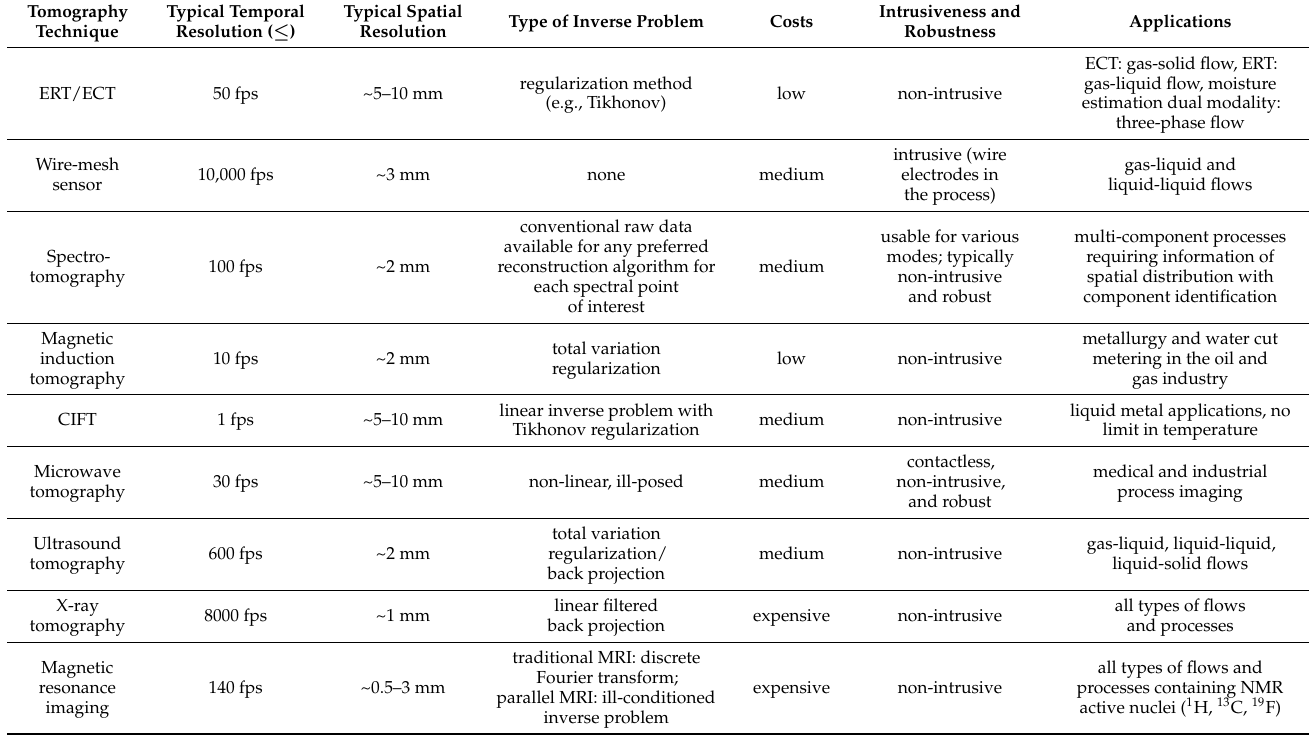
Table 1. Summary of the properties of process tomography modalities. Note: values for temporal and spatial resolution are for “the best” existing instruments. The “type of inverse problem” indicates the usual associated reconstruction and data processing effort. Of course, direct project data processing, e.g., via machine learning approaches, may be an option to reduce computational effort as indicated in many places in this paper. However, then we would rather no longer refer to it as